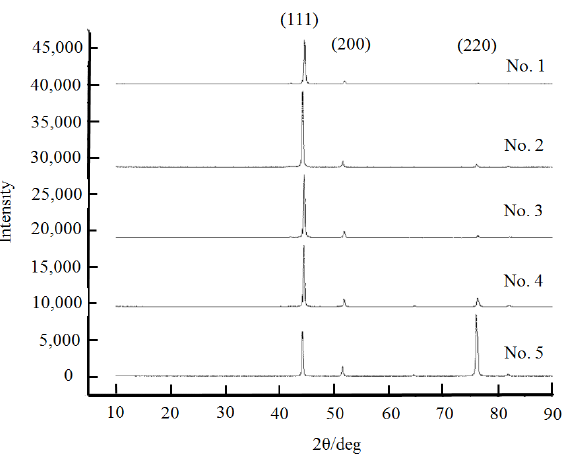
Figure 11. XRD diffraction patterns of five selected representative samples.